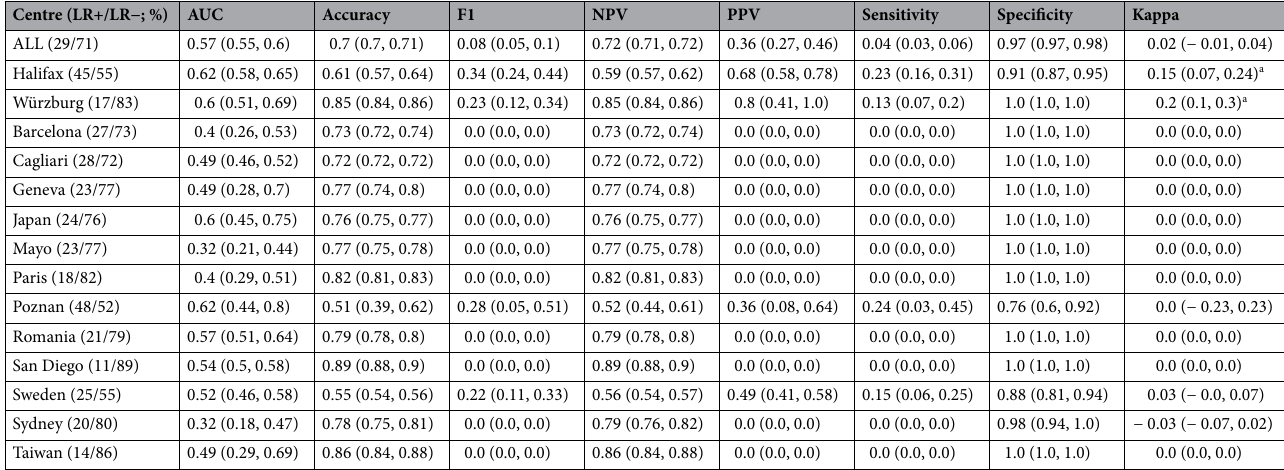
Table 3. Performance of the logistic regression (LR) classifier on the aggregate and site-level analyses. Table columns represent different classification statistics and values represent the mean of each statistic over five folds along with an empirical 95% confidence interval. In the column listing respective centres, we have included the percentage of lithium responders (LR+) and non-responders (LR−) in the format %LR+/%LR− to provide context for the classification results. Abbreviations: all sites (ALL; i.e. aggregate analysis), area under the receiver operating characteristic curve (AUC), positive predictive value (PPV), negative predictive value (NPV), F-1 score (F1). a Kappa value was found to have a p value less than 0.01 in comparison to the null